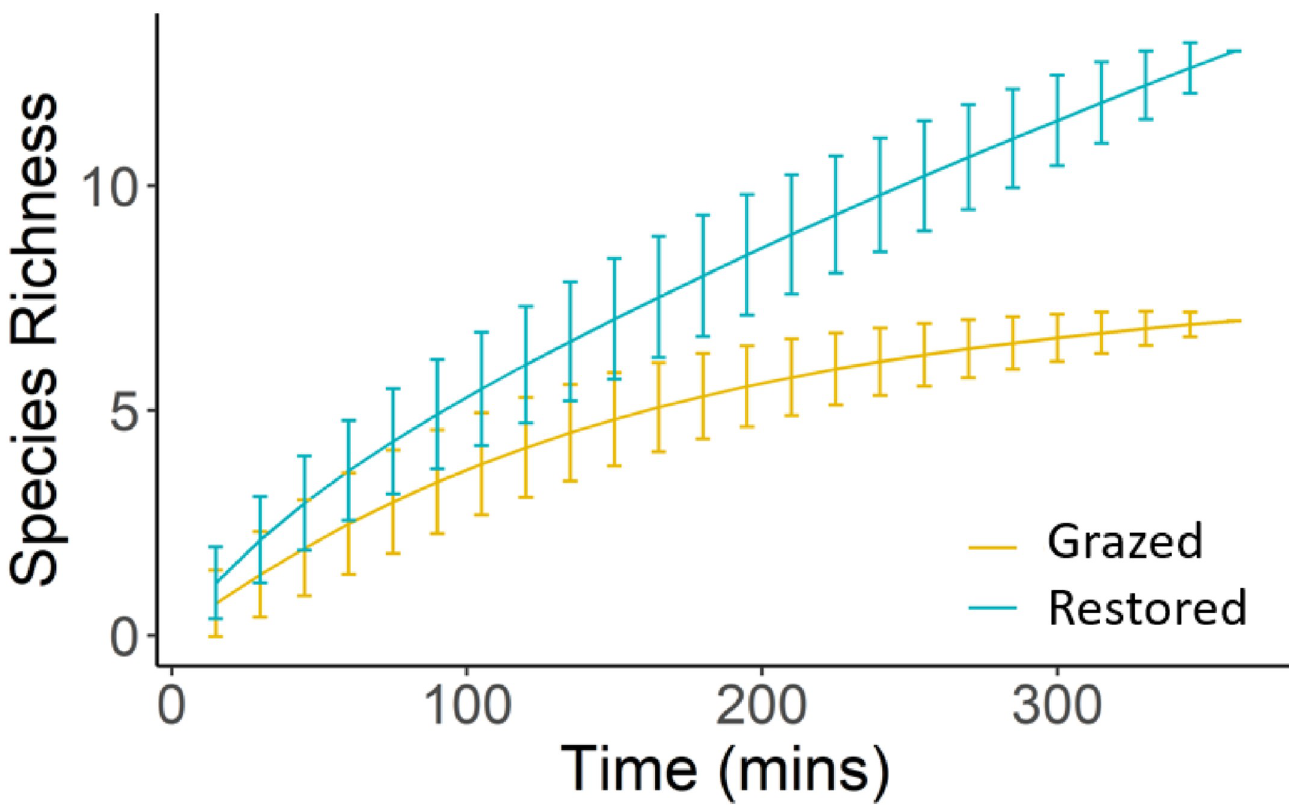
Fig 4. Mammalian species accumulation curves for dusk and night surveys carried out within the reserves’ grazed and restored gallery forest islands. Lines represent the mean species richness per cumulative 15m time band. Error bars represent the standard deviation from that mean.